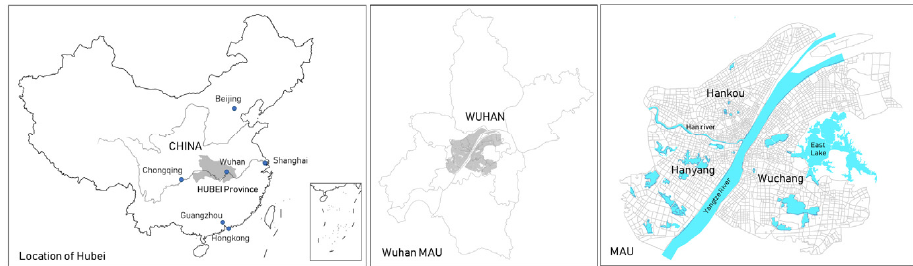
Figure 1. Location of Wuhan and its Main Urban Area (MUA).